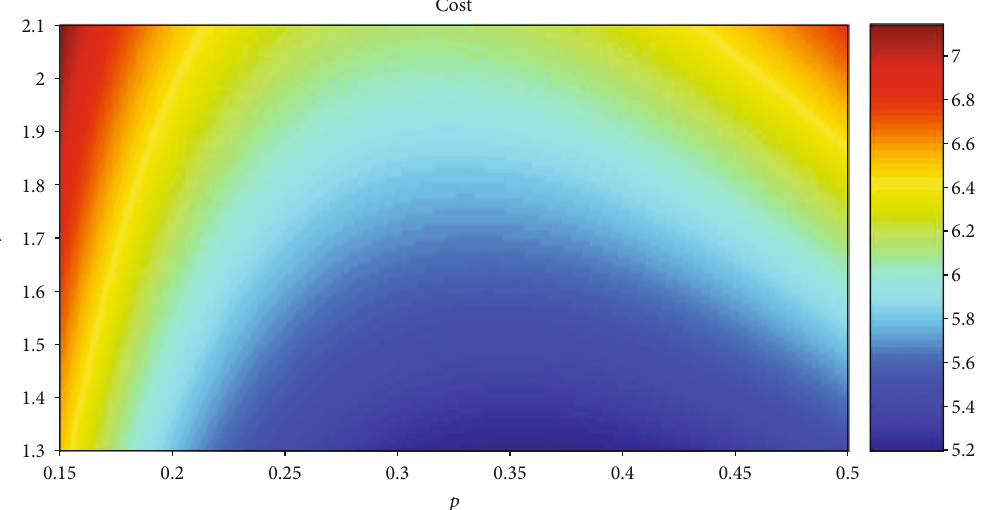
Figure 15: The relationship between cost and p and r